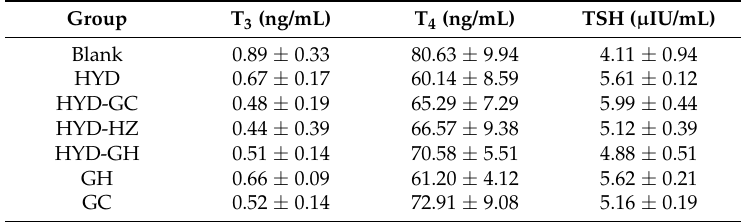
Table 11. The T 3 , T 4 and TSH levels in serum of the model rats in different